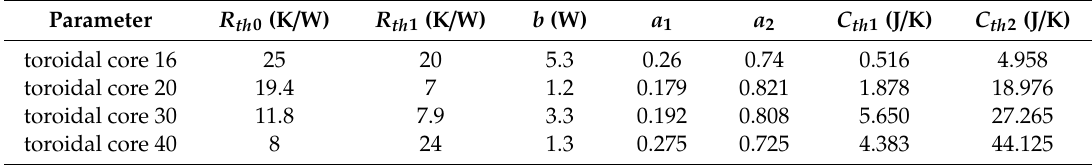
Table 7. Values of parameters describing Z thw ( t ) of inductors with toroidal